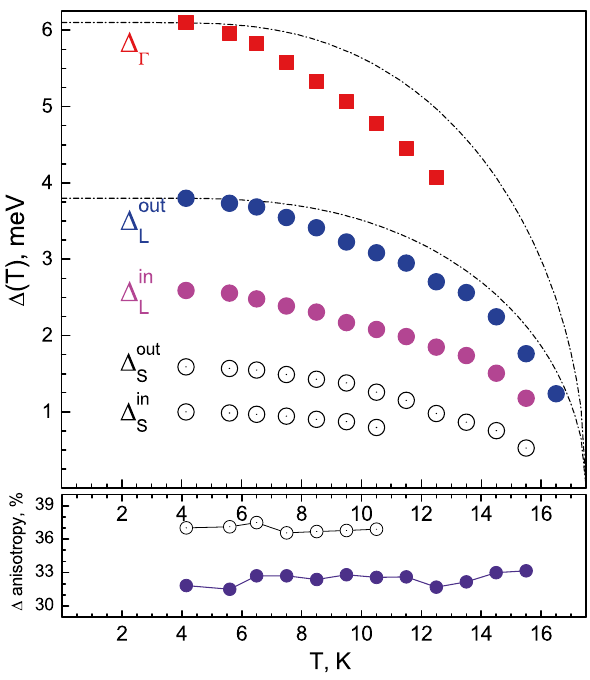
Fig. 6 Temperature dependences of the normalized order para- meetrs 2 Δ i ( T )∕ k B T c : the largest superconducting gap Δ Γ (red sym- bols), the edges of the anisotropic Δ L gap (blue and magenta sym- Fig. 5 Temperature dependences of the superconducting gaps for bols), and the edges of the possibly anisotropic small gap Δ S (black the array shown in Fig. 4. The Δ out L ( T ) and Δ in L ( T ) gap edges are symbols). The data taken from Fig. 3 are shown by cicrles, the data shown by solid blue and magenta circles, respectively, the small from Fig. 5—by squares. For comparison, our early data for an array gap Δ S ( T ) dependence—by open black circles. In the lower panel, with T local c ≈ 15.6 K (taken from [21]) are shown by gray rhombs. the gap anisotropy A ( T ) temperature dependence of the Δ L -gap Single-band BCS-like curves are presented by dash-dot (violet circles) and possibly anisotropic Δ S -gap (open circles) is pre- Δ in ( T ) ] sented, taken as A ( T ) ≡ 100 % ⋅ [ 1 − Δ out ( T ) | |